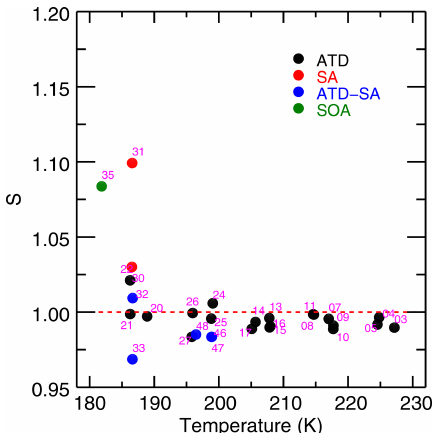
Figure 3. Average measured saturation of the 28 IsoCloud exper- iments after relaxation back to a near-constant value. Supersatura- tions plotted are the average value of the final 200s of pumping. Ex- periments are colored by aerosol/IN type: Arizona test dust (ATD, black), liquid sulfuric acid droplets (SA, red), secondary organic aerosol (SOA, green), and experiments containing both ATD and SA (blue). Warm, cirrus-dominated experiments ( T ≥ 195K) typi- cally show vapor pressures close to MK, with saturations from 0.98 to 1.00. Cold, wall-dominated experiments (below ∼ 195K) show saturations that rise with decreasing temperature. Higher supersatu- ration is necessary for the cirrus growth rate to match the mass flux off the chamber walls. This effect means that an ice growth model is necessary to extract the saturation vapor pressure. Water vapor retrievals during the pumping interval in Experiment 33 are quite subsaturated with respect to